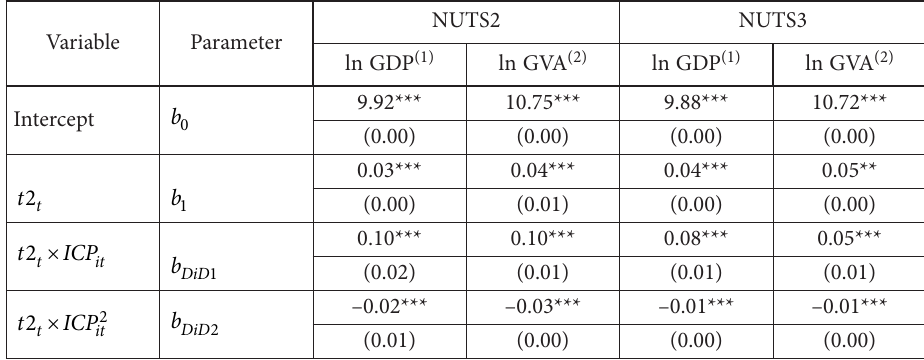
Table 3. Fixed effects estimates of 2007–2013 programming